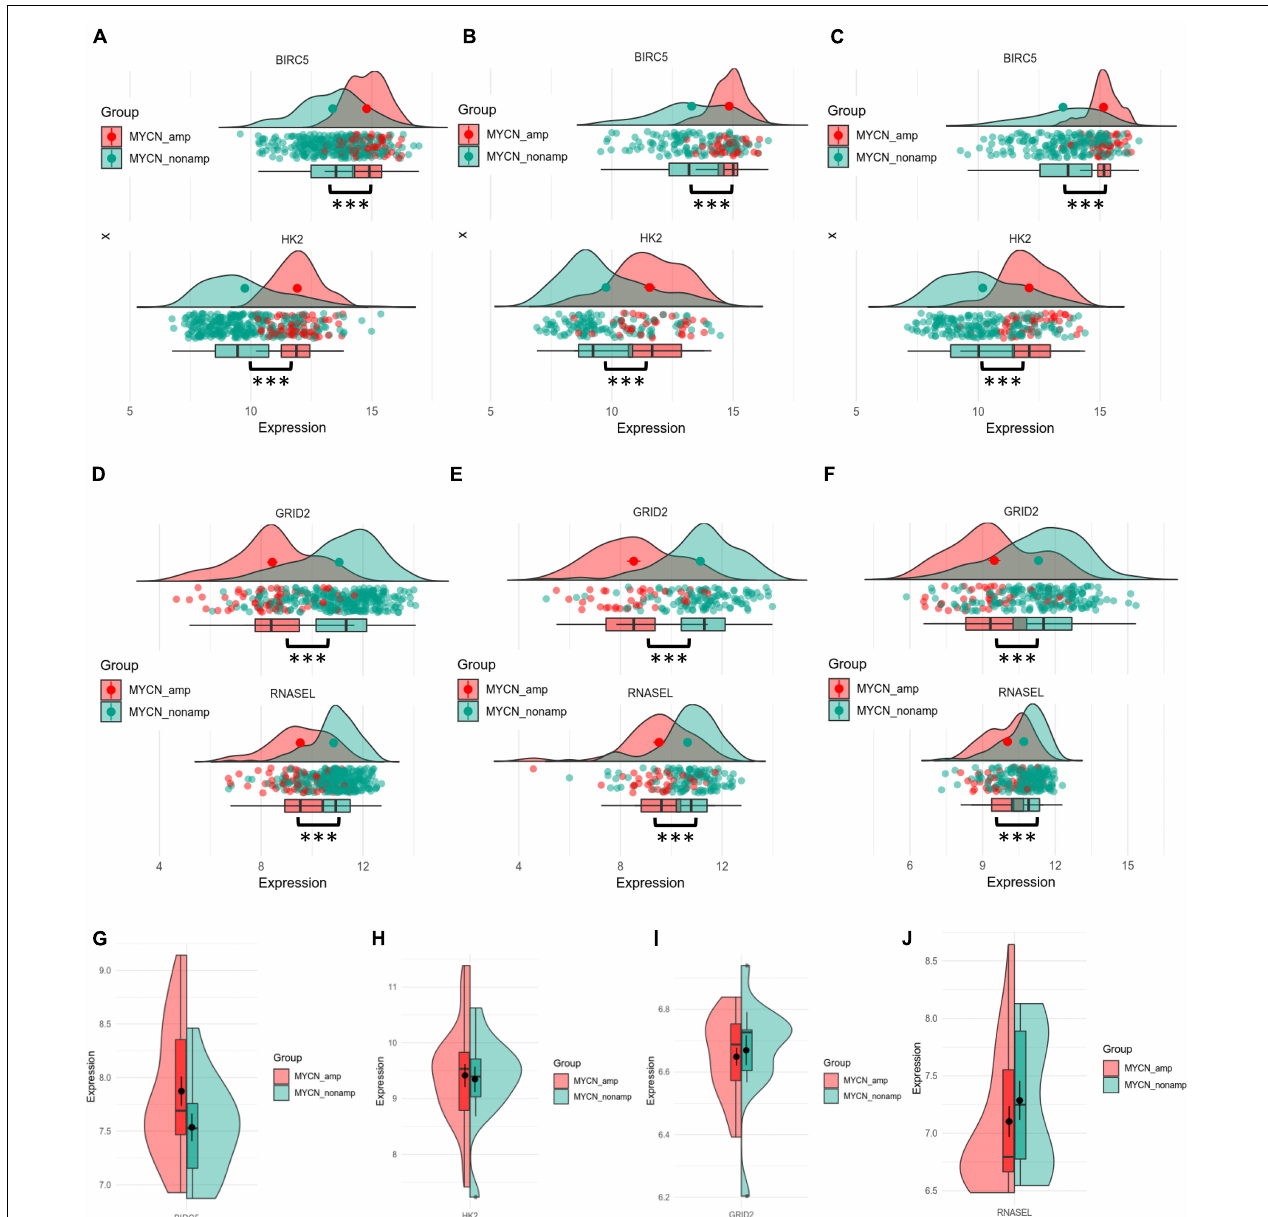
FIGURE 3 | Differential expression of four hub ATGs between MYCN amplification and MYCN nonamplification in tissue samples and cell lines. Different expression of BRIC5 and HK2 in tissue samples between MYCN amplification and MYCN nonamplification of training cohort (A) , internal (B) , and external validation (C) . Different expression of GRID2 and RNASEL in tissue samples between MYCN amplification and MYCN nonamplification of training cohort (D) , internal (E) , and external validation (F) . Different expression of BRIC5, HK2, GRID2, and RNASEL between MYCN amplification and MYCN nonamplification in NB cell lines (G–J) .